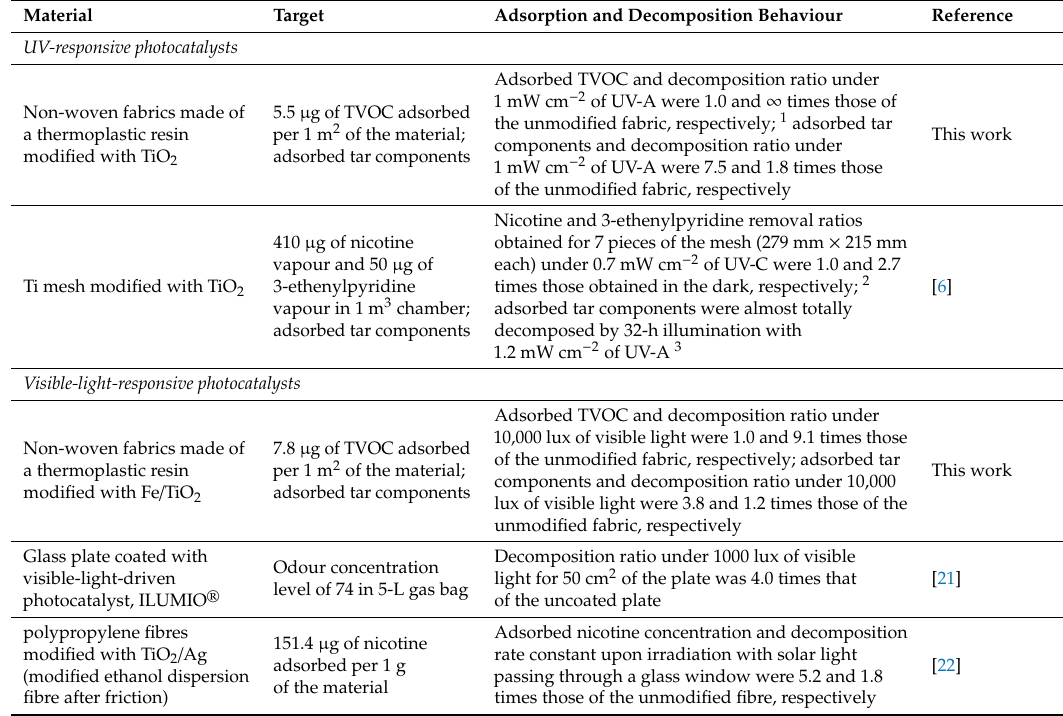
Table 1. Comparison of photocatalyst systems used for the removal of tobacco smoke